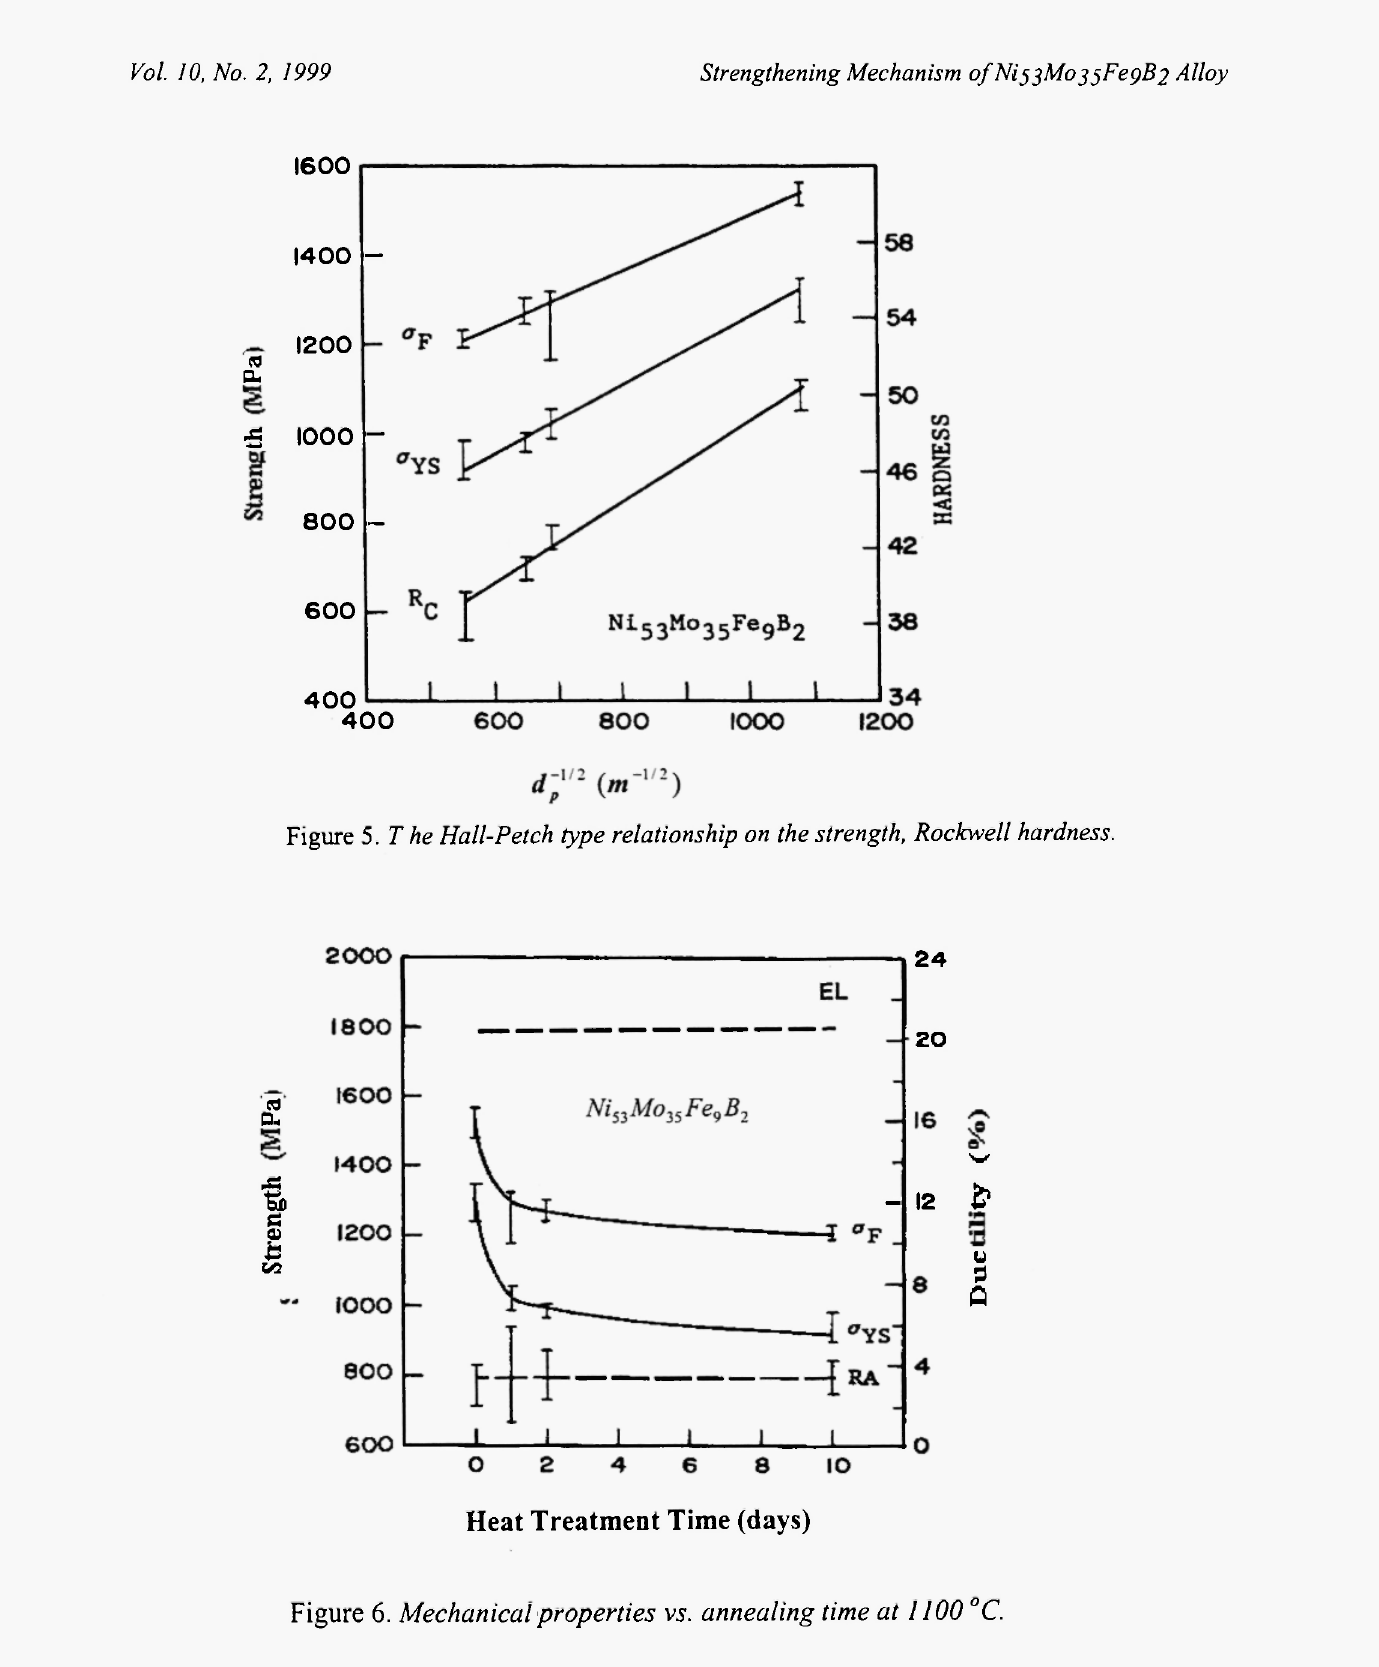
Figure 6. Mechanical properties vs. annealing time at 1100